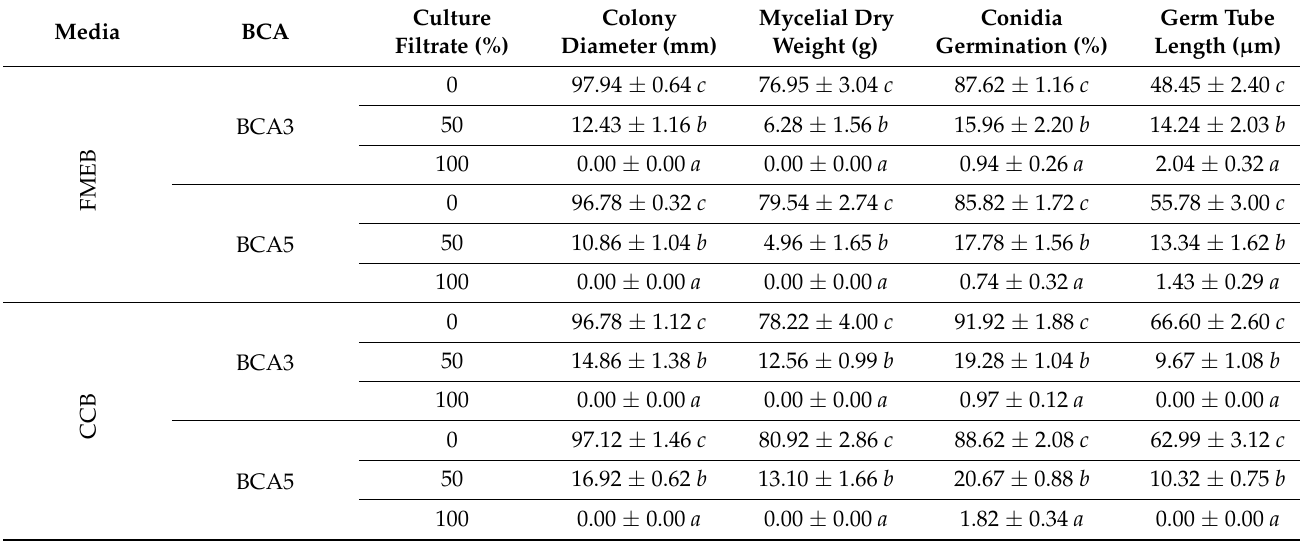
Values are means ± SE of eight replicates. Values with the same letter within a column for each BCA are not significantly ( p > 0.05) different, according to Duncan’s multiple range test. BCA3 (isolate #21) and BCA5 (#45) represent Streptomyces griseorubens and S. wuyuanensis ; respectively. FMEB, fish meal extract broth; CCB, colloidal chitin broth; BCA, biological control